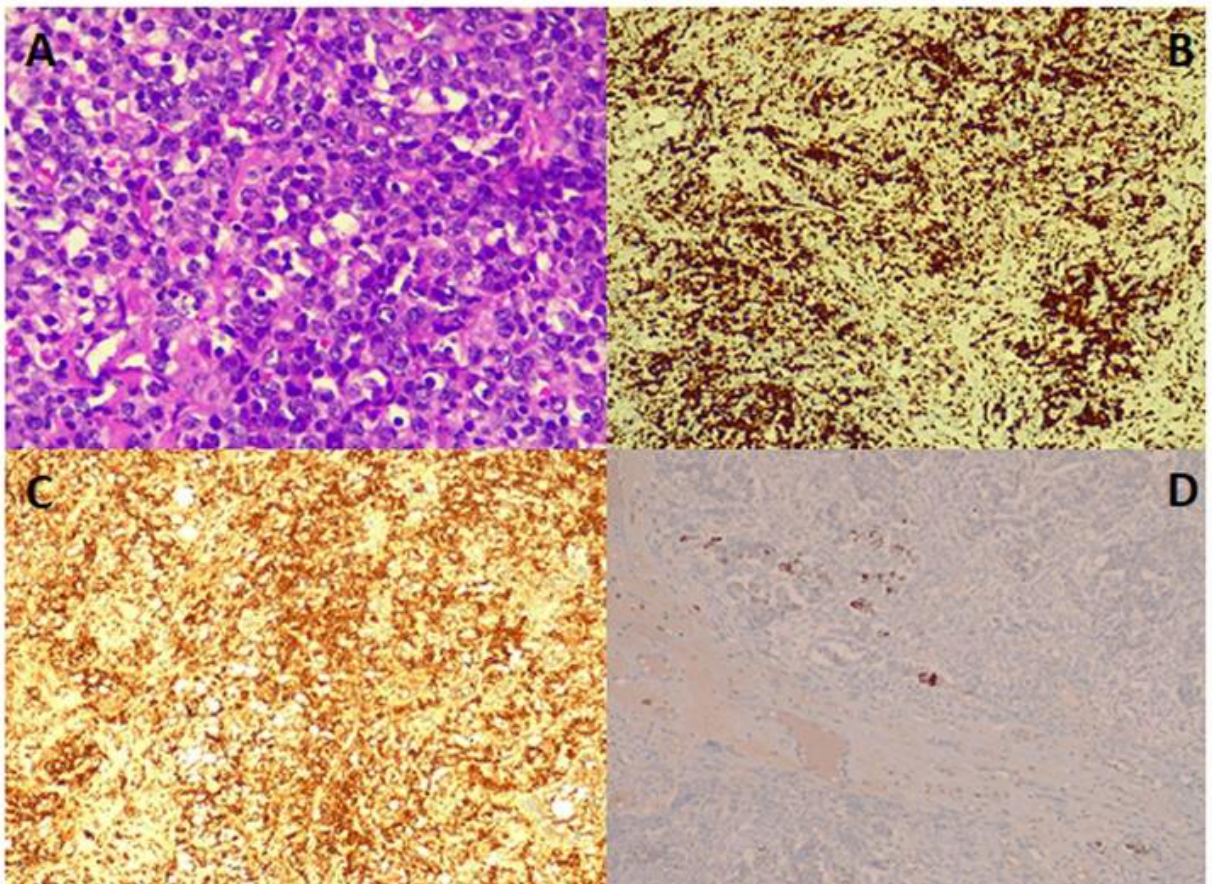
Figure 3 : A: H&E showing sheets of atypical lymphoid cells (400X); B: Immunopositivity for ALK1(100X); C: Immunopositivity for CD 30(100X); D: Immunonegativity for CK